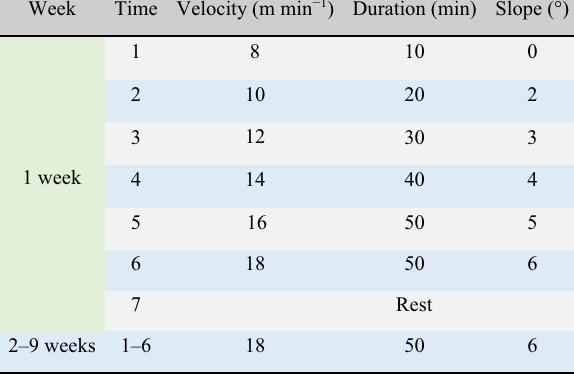
Table 1. 8-week-treadmill exercise